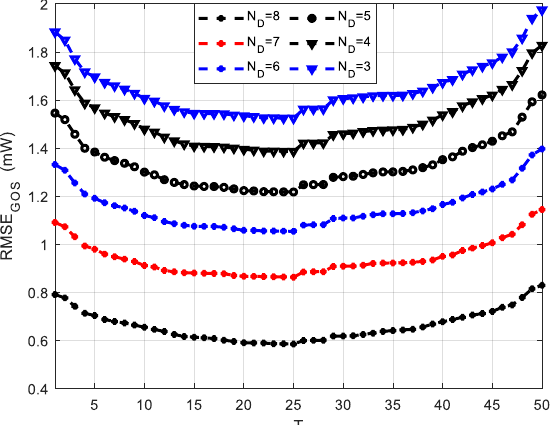
Figure 9. RMSE according to the number of the previous times slots